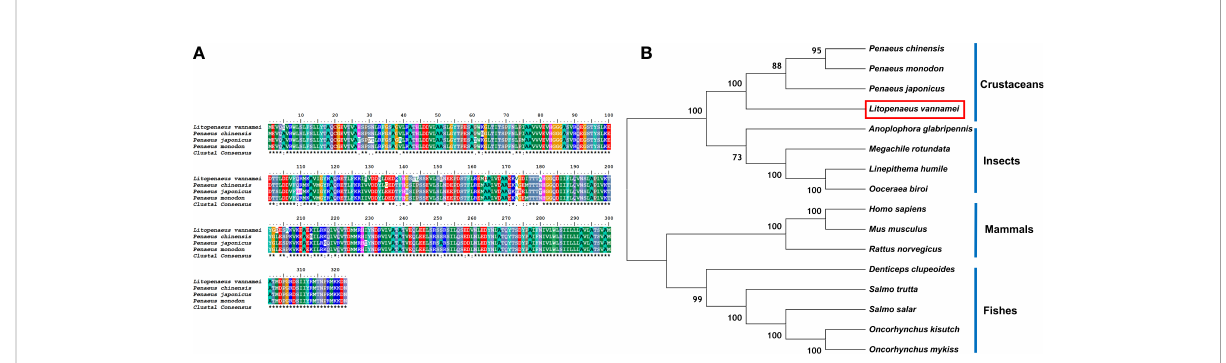
FIGURE 5 (A) Multiple alignments of deduced amino acids of LV-RR protein and its homologs. Species names are listed on the left side. (B) The phylogenetic tree shows relationships between the RR proteins of L. vannamei (red rectangle) and those of other organisms. Species names are listed to the right of the tree.